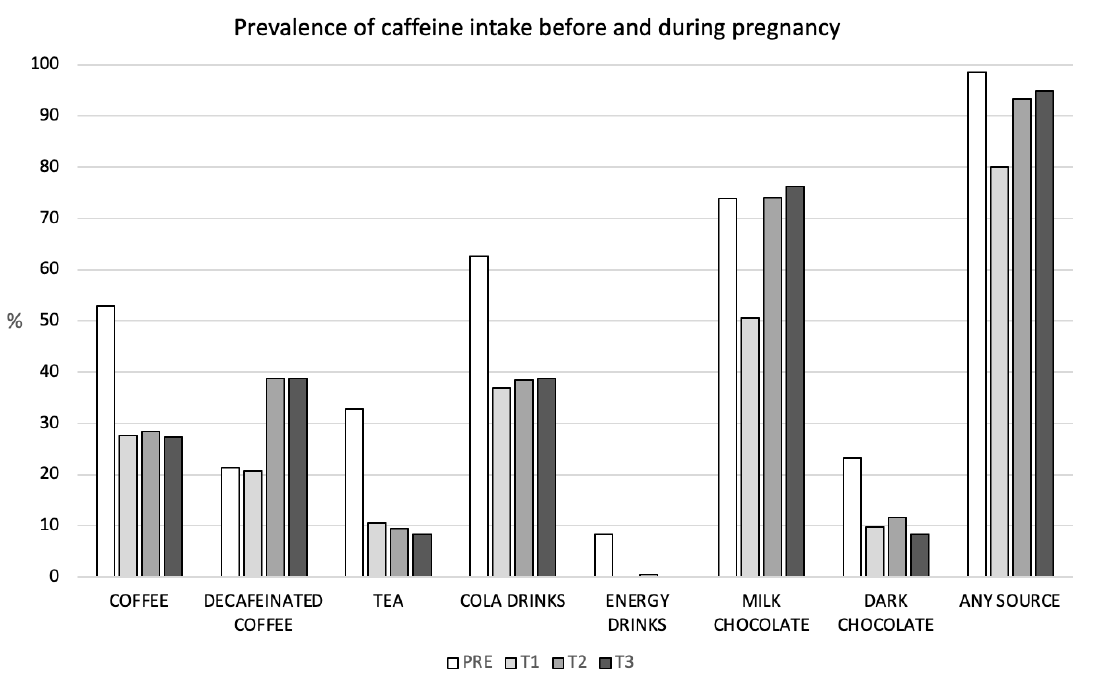
Figure 2. Prevalence of caffeine intake before and during pregnancy. T0 (pre-pregnancy), T1, T2, T3: first (12th gestational week), second (24th ± 2 gestational weeks), and third (at 32nd gestational week) trimester of gestation, respectively.